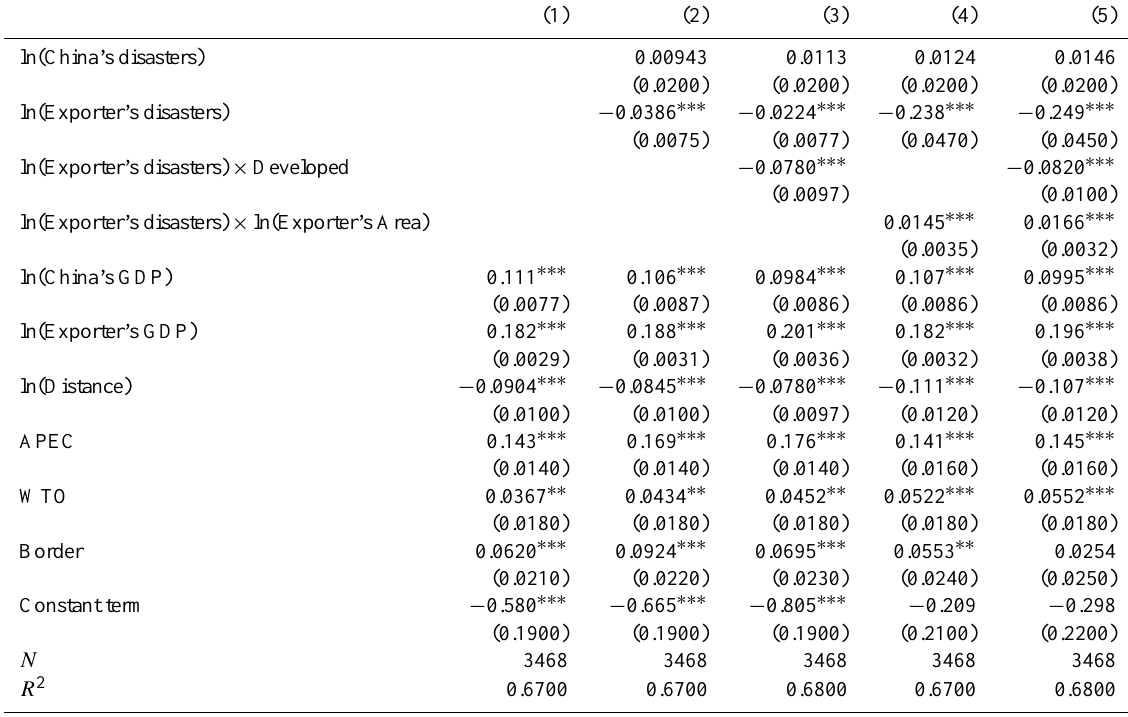
Table 5. Regression results for China as an importer